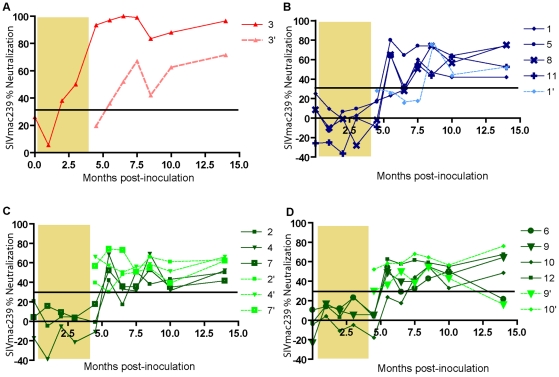
Autologous neutralization of SIVmac239.Purified IgG corresponding to 1∶20 dilutions were analyzed for neutralization of SIVmac239 in samples obtained at eleven different time points. Tenofovir treatment period is indicated by shaded area. (A) Development of neutralizing plasma titers against SIVmac239 inoculate in NC3 (3; red) and the 1st re-isolate (3′; pink), (B) in TC macaques against inoculate (dark blue) and reisolates (′; light blue). (C) and (D) Neutralization against inoculate in LC animals (dark green) and reisolates (′; light green). Values are means of two independent assays. Assay cut-off was 30% as indicated by line.